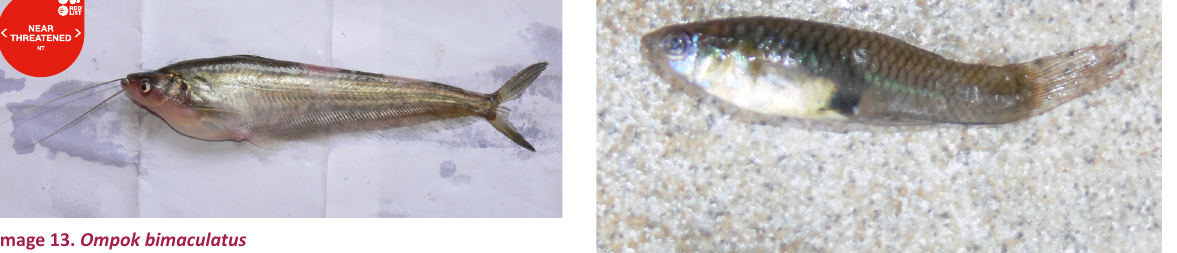
Image 13. Ompok bimaculatus